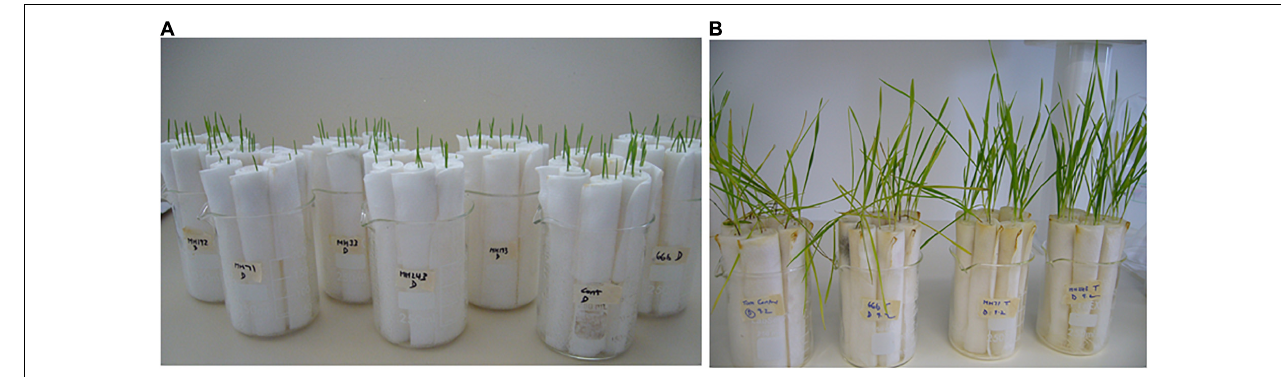
FIGURE 1 | Seedling-scale assay: F. pseudograminearum infected seedlings of wheat cv. Tamaroi at the time of inoculation (A) and at the time of scoring disease severity (B) .